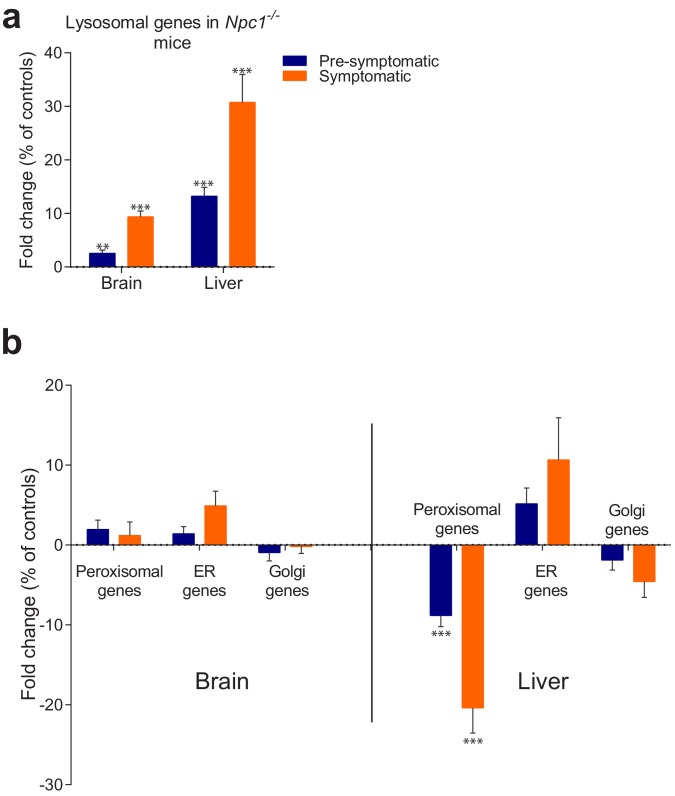
Behaviour of organelle-specific gene lists in NPC1 KO tissues.(a) The average expression of 435 lysosomal genes was higher both in brain and liver of NPC1 KO, even in asymptomatic mice, and increased further upon disease onset. (b) Expression of 86 Golgi-related and 297 endoplasmic reticulum (ER)-related genes did not change significantly between NPC1 KO and WT. Expression of 254 peroxisomal genes was not affected in NPC1 KO brain, but was significantly reduced in asymptomatic NPC1 KO liver and decreased further upon disease onset. The plots represent average fold change ± s.e.m. for all genes in the organelle-specific list. T-test p-value (comparing each organelle list in NPC1 KO and WT) with Bonferroni correction, **p<0.01 ***p<0.001, n = 6 (NPC1 KO and WT liver), n = 5 (NPC1 WT brain) and n = 11 (NPC1 KO brain).